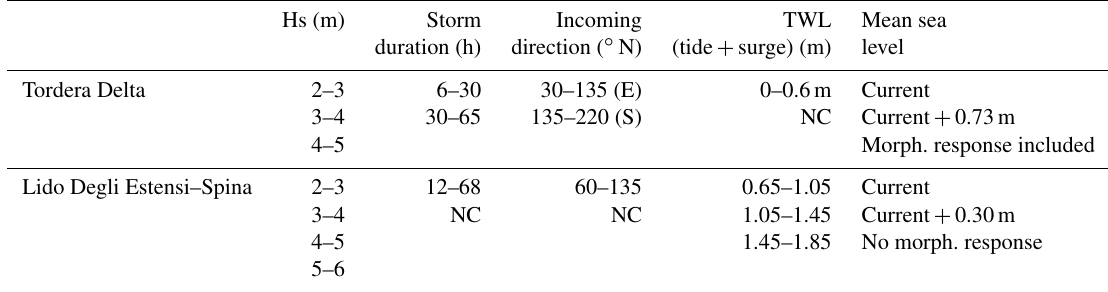
Table 1. Source characterisation. Variable discretisation applied at the study sites. NC denotes a variable not considered in a study case and therefore not divided in